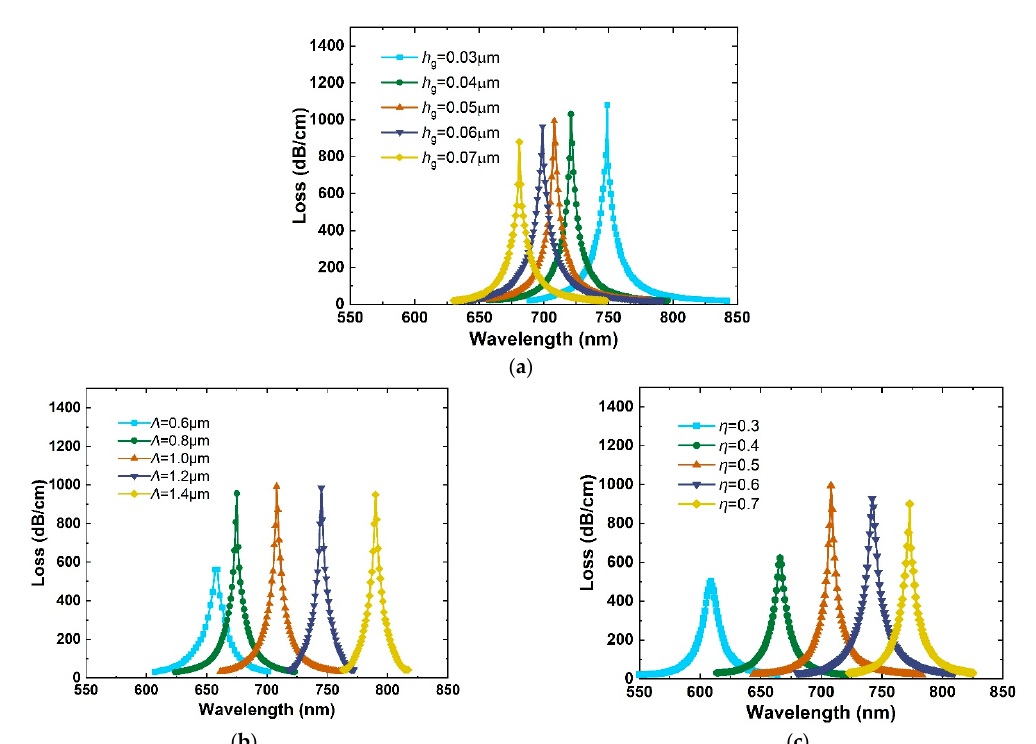
Figure 7. Response curve of con fi nement loss with di ff erent ( a ) grating heights h g , ( b ) grating pe ‐ riods Λ , and ( c ) the grating duty η . Λ , and ( c ) the grating duty η